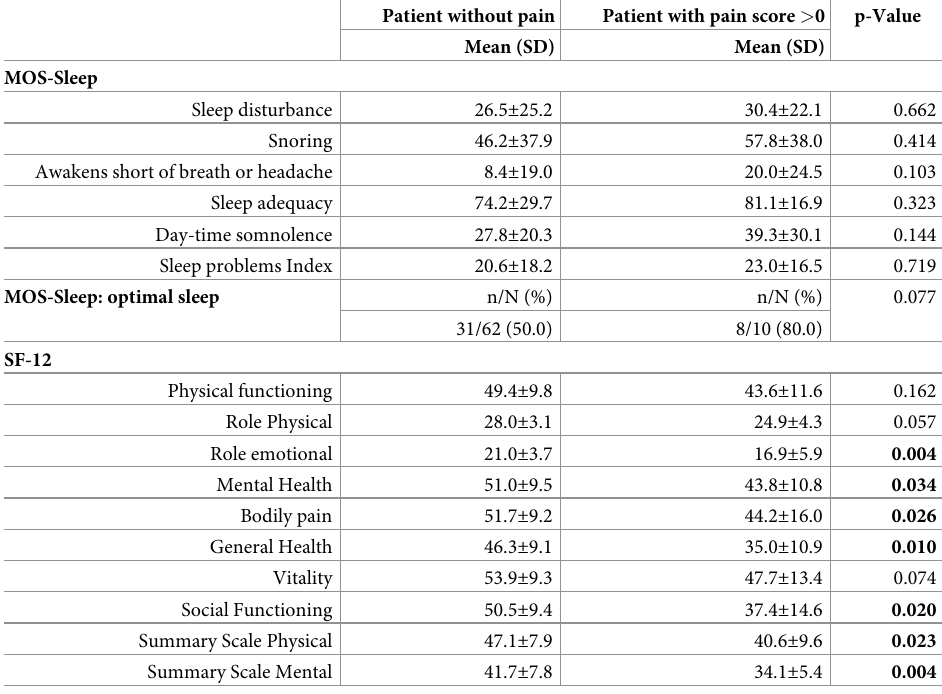
Table 5. Sleep problems and quality of life in patient with pain score > 0 at week